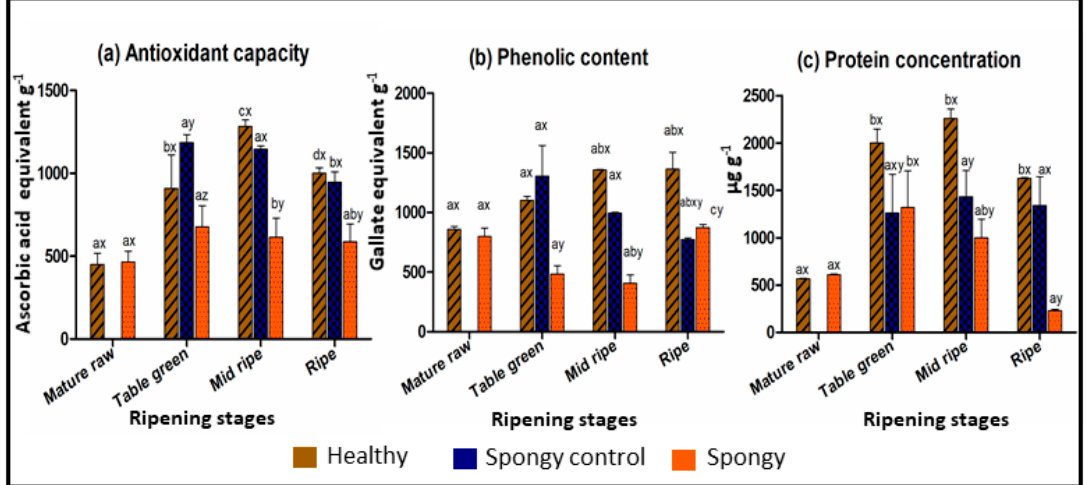
Figure 2. Biochemical assay. Average concentration of ( a ) antioxidant capacity in ascorbic acid equivalents per gram of tissue (AAE/g) ( b ) phenolic content in gallic acid equivalents per gram of tissue (GAE/g) and ( c ) protein concentration in µg/g of healthy, spongy control and spongy tissue mesocarp of Alphonso mango fruit at various ripening stages. Vertical bars represent standard error calculated from six biological replicates. Difference between the stages of each tissue set was significant ( p ≤ 0.05) if lower case letters (a, b, c) are different. Difference between the tissue sets at each ripening stage was significant ( p ≤ 0.05) if lower case letters (x, y, z) are different.